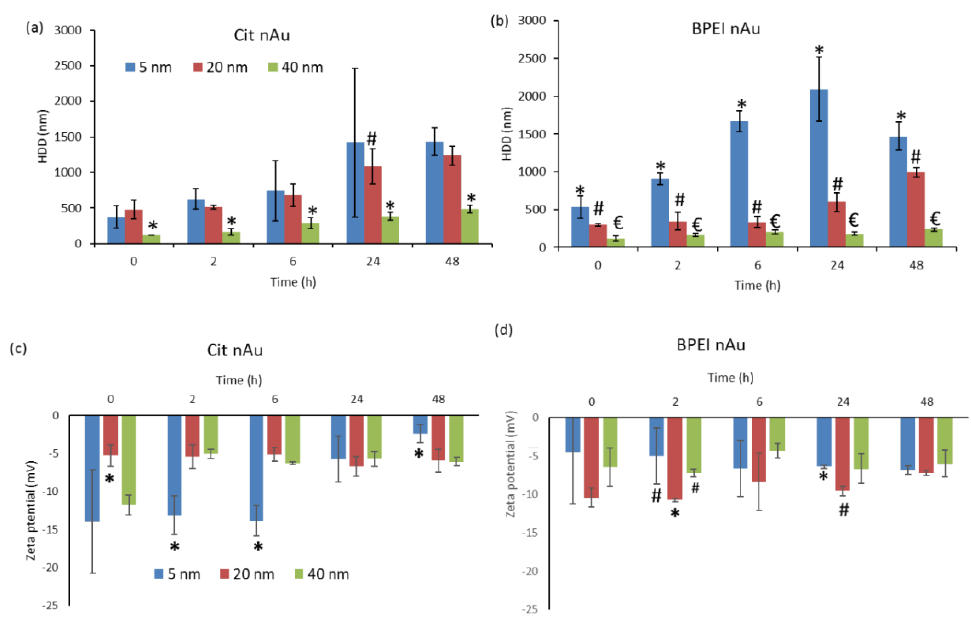
Figure 1. Hydrodynamic diameter ( a , b ) and zeta potentials ( c , d ) of gold nanoparticles at 1000 µg/L in 10% Hoagland’s medium measured using Dynamic Light Scattering technique over 48 h. Data are presented as mean ( n = 3), bars denote standard deviations (SD), and different symbols denotes significant differences between nAu sizes per time period. nAu concentrations < 1000 µg/L were below detection limit using Zetasizer.